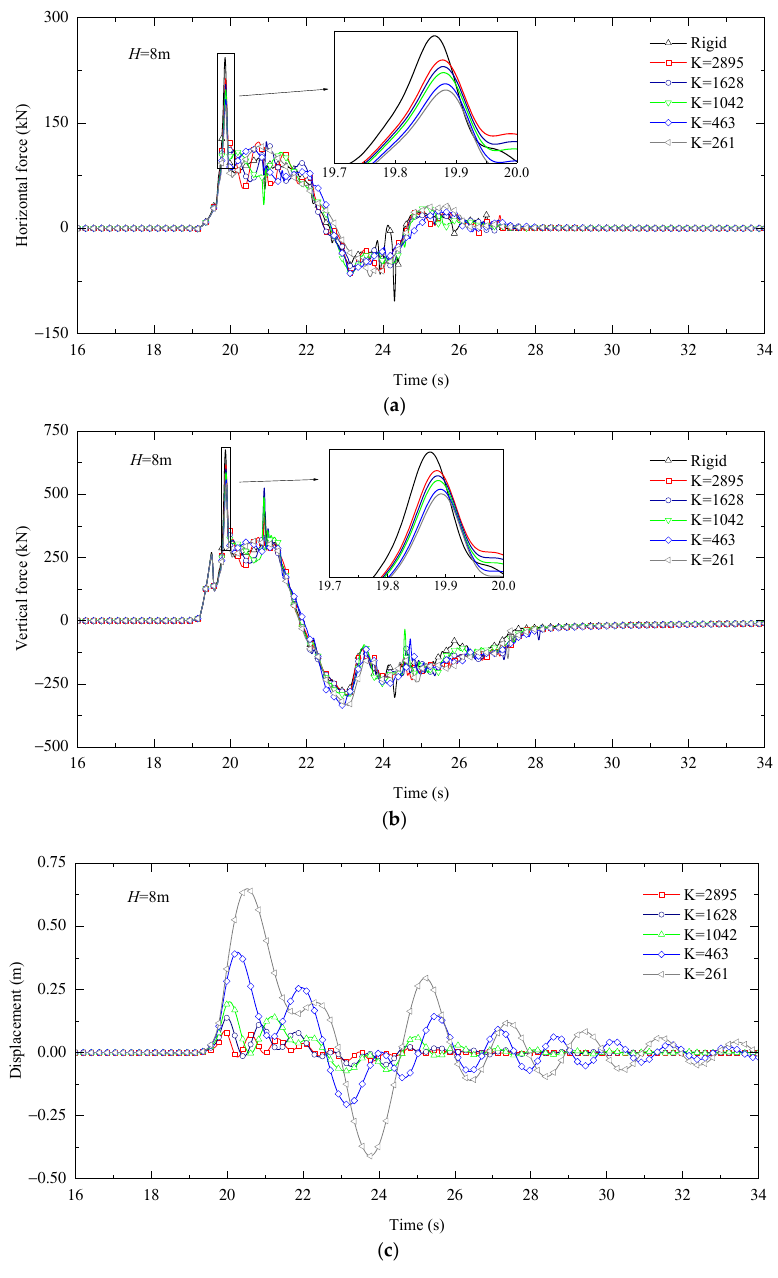
Figure 17. Example of the box-girder superstructure–wave interaction for Case E23/Cs (1). ( a ) Comparison of the time histories of horizontal force; ( b ) Comparison of the time histories of vertical force; ( c ) Comparison of the time histories of displacement.